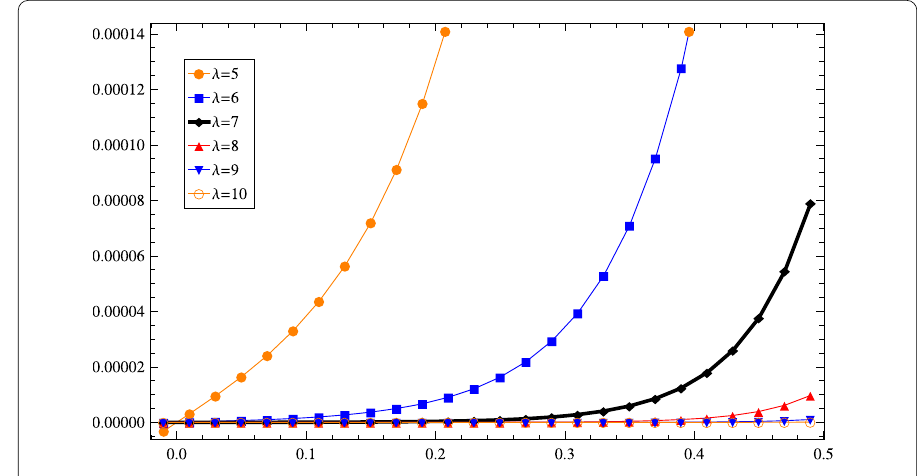
Figure 7 Plot of a numerical solution of approach I for ν 0 = 0, λ = 5, ... ,10, and n = 1 in [0,0.5]